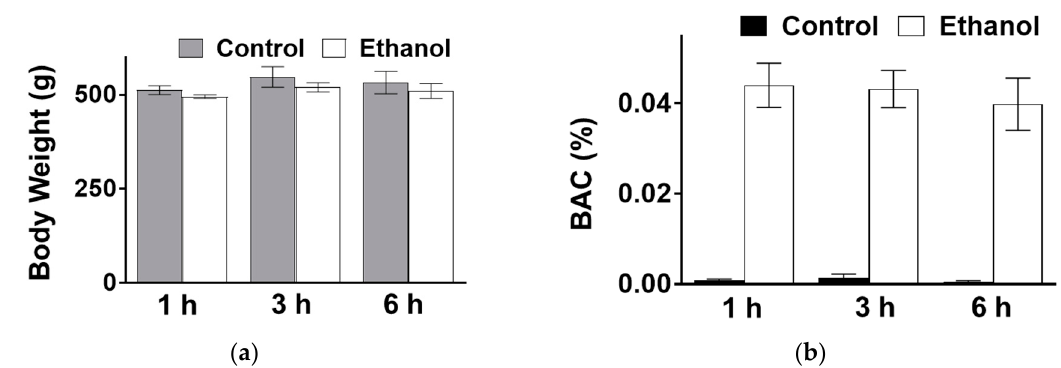
Figure A1. Establishment of the intragastric gavage model in Sprague Dawley (SD) rats using a moderate dosage of ethanol. ( a ) The body weights of 16-week-old SD rats did not differ between treatment groups ( p > 0.05, n = 4). ( b ) Rats were administered a 2 g/kg dosage of ethanol or water. The BAC of the rats administered ethanol reached 0.04%. P-values were adjusted for multiple hypotheses using a Bonferroni correction (* 1 h: p < 0.01; 3 h: p < 0.01, 6 h: p < 0.05; n = 4). The error bars represent the standard error of the mean (SEM).